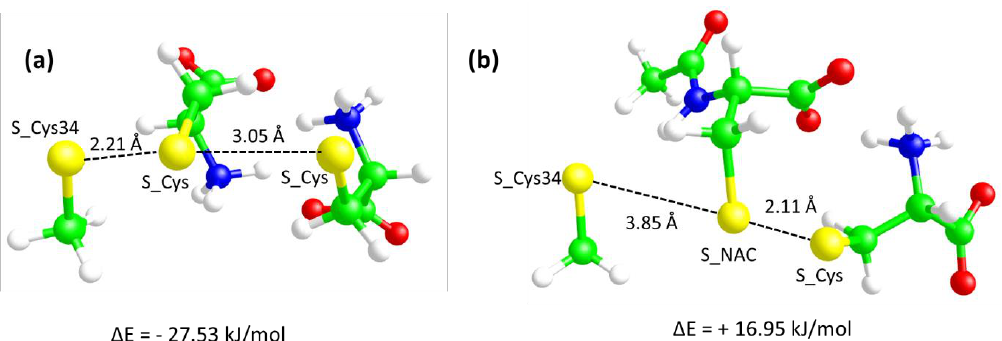
Figure 6. Molecular Modeling studies: Structures of the two studied trisulfide intermediates-Cys-Cys- C34 ( a ) and Cys-Nac-C34 ( b ) as optimized by DFT calculations by simulating the water effect using the PCM method. The relative energies with respect to the isolated reactants are also reported.